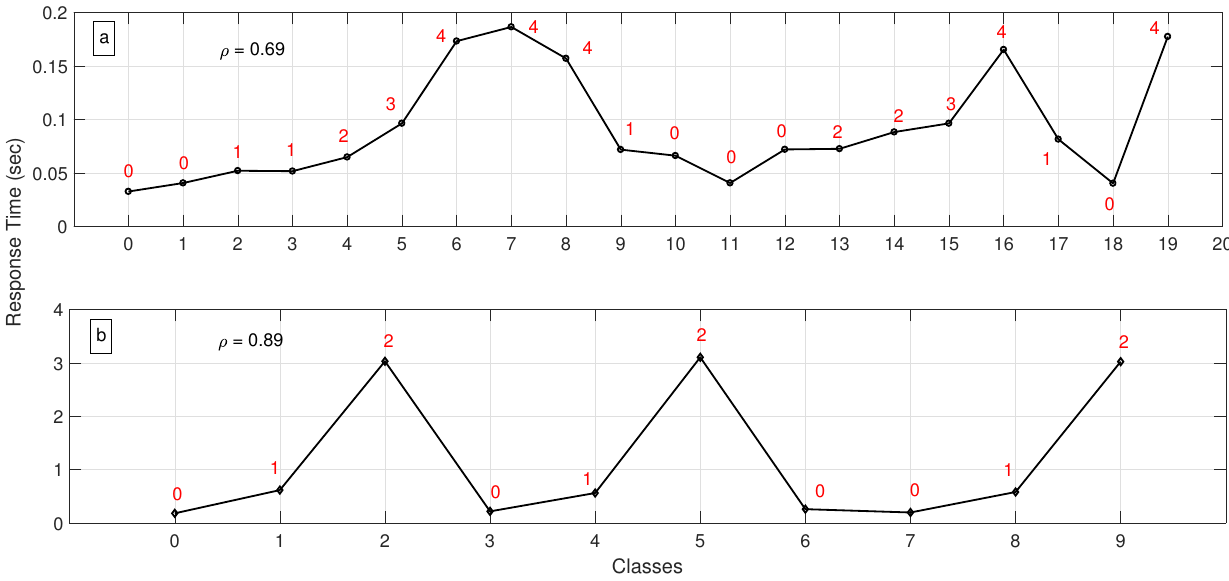
Figure 8. Response time for various classes of messages assigned with different priority